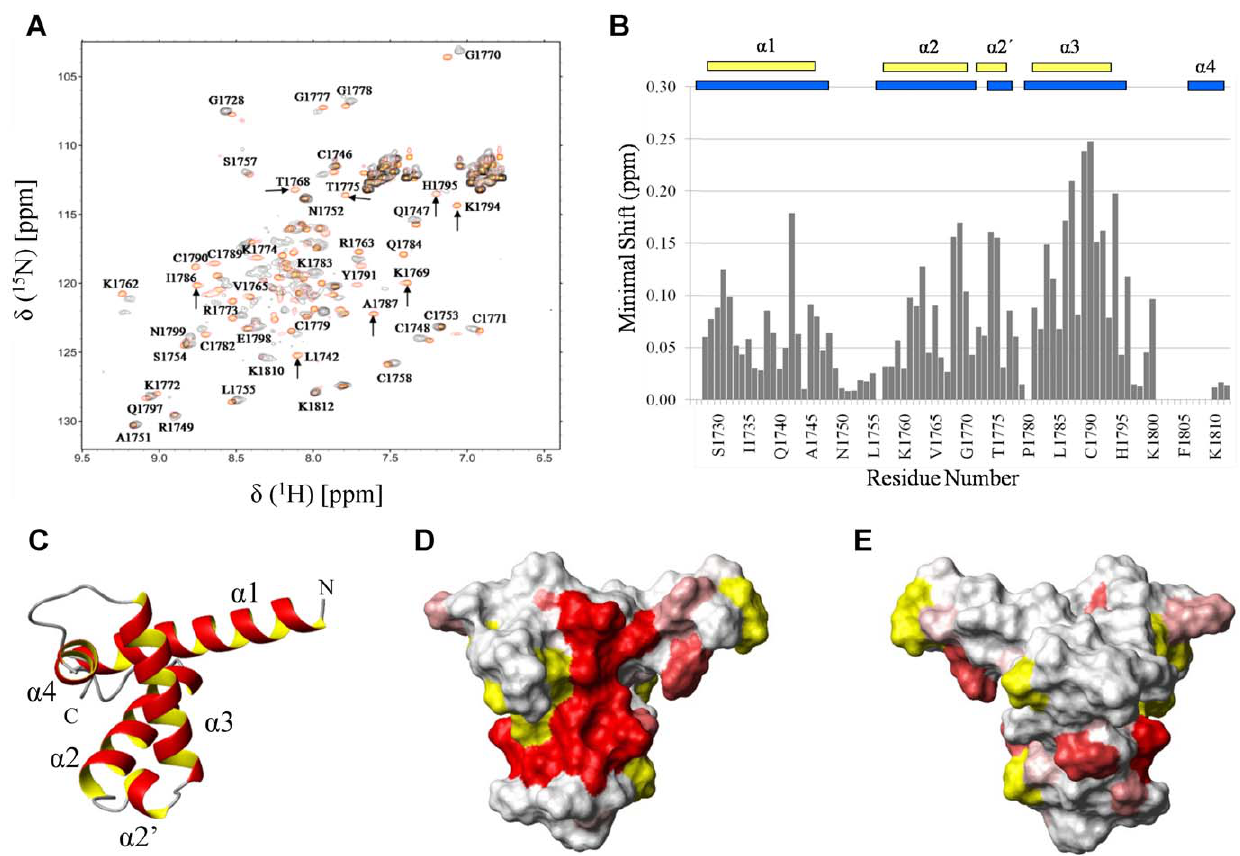
Figure 5. Identification of the B-Myb TAD binding site on p300 TAZ2. Panel A shows an overlay of two 15 N/ 1 H HSQC spectra of 15 N labeled p300 TAZ2 (100 m M) acquired in the absence (red) or presence of equimolar unlabelled B-Myb TAD (black). The arrows highlight a number of TAZ2 signals which show significant shifts on interaction with the B-Myb TAD. Panel B contains a histogram summarizing the minimal chemical shift changes observed for backbone amide signals of p300 TAZ2 on binding to B-Myb TAD, with gaps corresponding to proline residues (1727, 1756, 1780, 1802 and 1804) or non-observable backbone amides. The combined amide proton and nitrogen chemical shift difference ( Dd ) was defined q ffiffiffiffiffiffiffiffiffiffiffiffiffiffiffiffiffiffiffiffiffiffiffiffiffiffiffiffiffiffiffiffiffiffiffiffiffiffiffiffiffiffiffiffiffiffiffi D d HN ð Þ 2 z D d N : a N ð Þ 2 where a N is a scaling factor of 0.2 required to account for differences in the range of according to the calculation D d ~ amide proton and nitrogen chemical shifts. The reported positions of the helices in CBP TAZ2 (blue bars, [30]), together with those determined for p300 TAZ2 (yellow bars), are shown above the histogram. Panel C shows a ribbon representation of the backbone structure of the TAZ2 domain of CBP [30] and panel D a contact surface view in the same orientation. In panel E the surface view of CBP TAZ2 has been rotated by 180 u about the y axis. The contact surfaces have been coloured according to the magnitude of the minimal shifts induced in backbone amide resonances of equivalent residues in p300 TAZ2 by binding of the B-Myb TAD. Residues that showed a minimal shift change of less than 0.075 ppm are shown in white, over 0.15 ppm in red, and between 0.075 and 0.15 ppm are coloured according to the level of the shift on a linear gradient between white and red. No chemical shift perturbation data could be obtained for the residues shown in